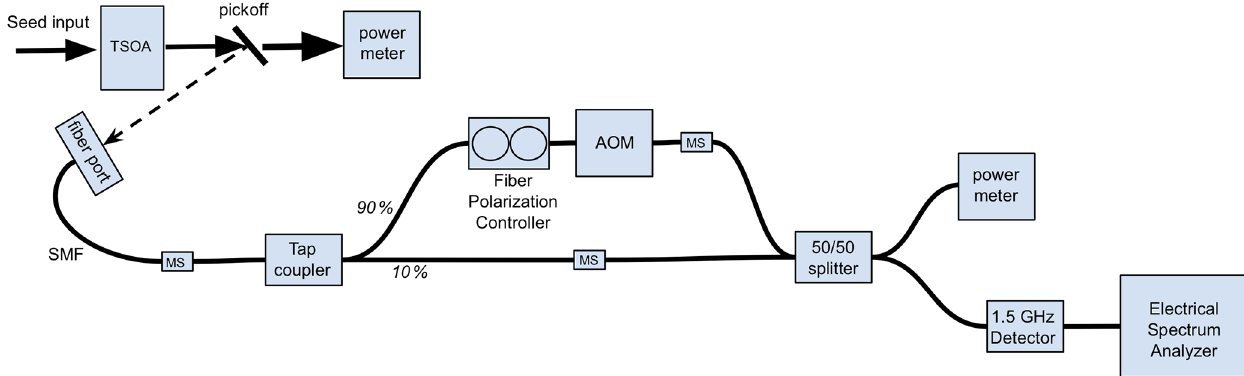
Figure A1. Test setup to measure the linewidth and spectral purity. AOM: acousto-optic modulator, MS: mating sleeve, SMF: single-mode fiber, TSOA: tapered semiconductor optical